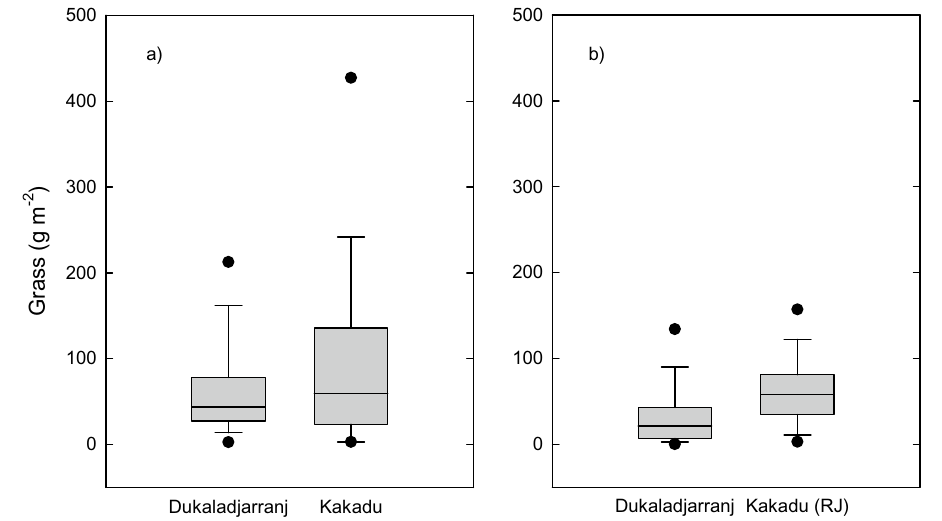
Figure 6. Grass biomass sampled in transects on Eucalyptus sand sheet savannas in Kakadu National Park and the Dukaladjarranj Aboriginal estate in central Arnhem Land. ( a ) Grass biomass was sampled in eight 0.25 m 2 quadrats per 100 m segment of transect. Total transect length was 2.0 km at Dukaladjarranj and 3.2 km in Kakadu (see "Materials and Methods" Section). ( b ) Box plots showing loads of grass and litter fuels sampled in four 0.25 m 2 quadrats in circular plots (10 m radius) surrounding living C. intratropica trees at Round Jungle (RJ) in Kakadu National Park and Dukaladjarranj (Fig. S1). Boxes span the interquartile range, the solid line indicates the median, the whiskers the 10th and 90th percentiles and solid circles, 5% and 95%